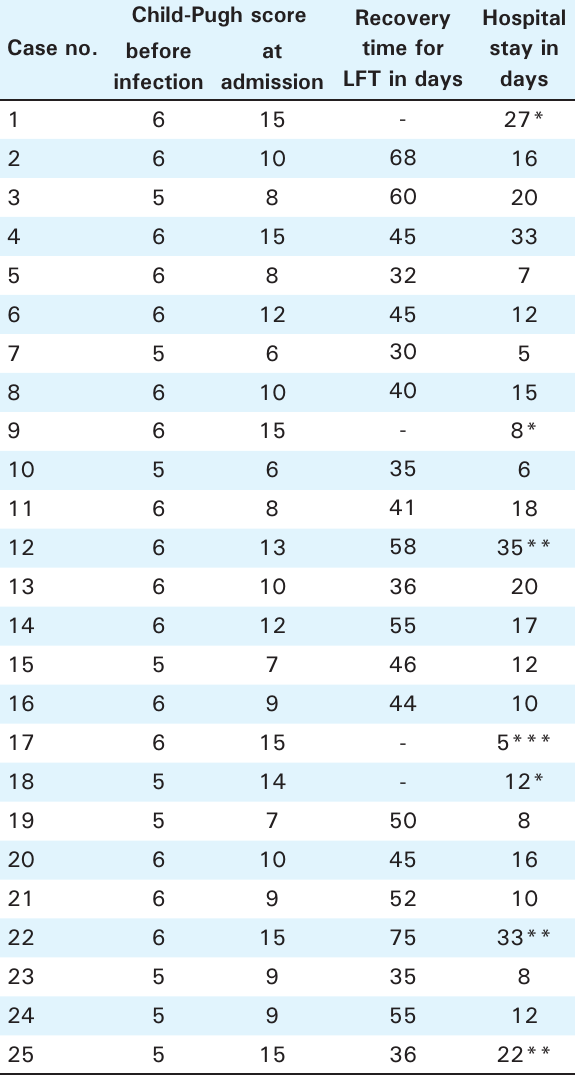
KC et al. Effect of Acute Hepatitis E Infection in Patients with Liver Cirrhosis Table 3. Outcomes of study population after superinfection with HEV hepatitis. Child-Pugh score Case no.